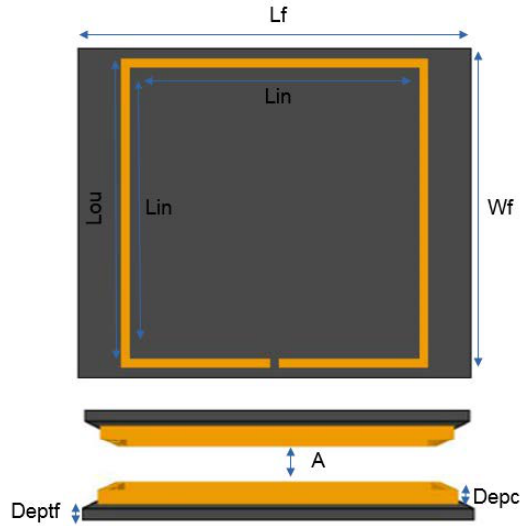
Figure 9. Coupler dimensions. Table 2. Coupler dimensions.